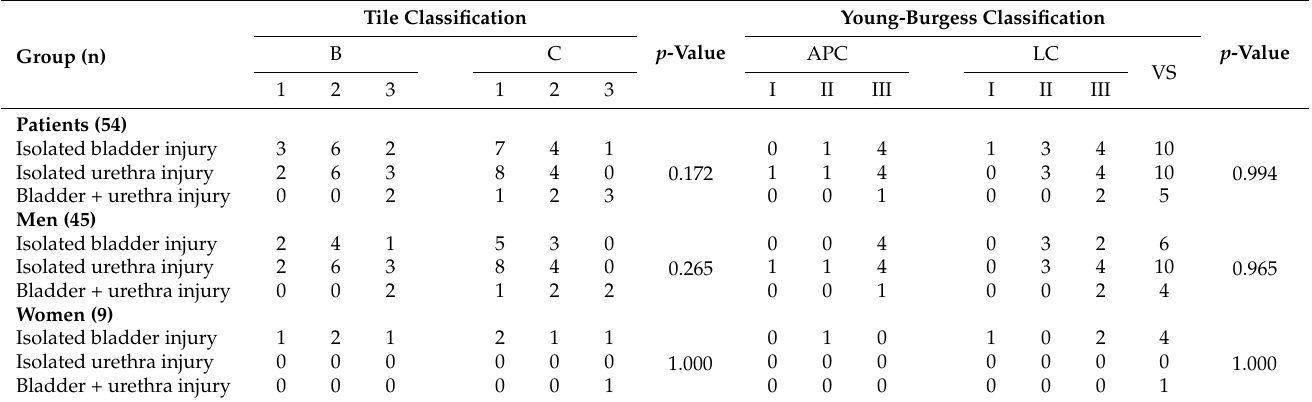
Table 2. The distribution of pelvic fracture types with LUTIs according to the Tile classification